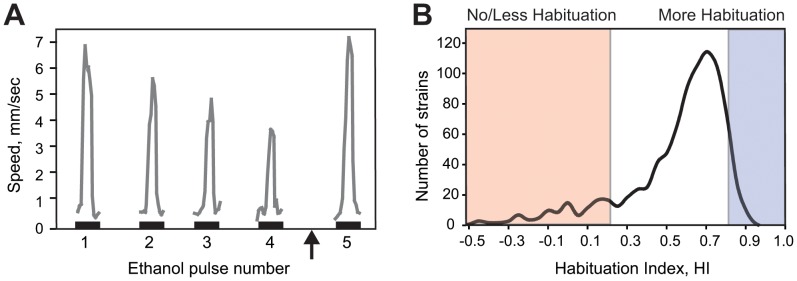

Drosophila habituates to an ethanol-induced olfactory startle.
A) The olfactory startle attenuates with the characteristics of habituation. Ethanol naïve flies exposed to a 30-sec pulse of ethanol vapor showed an olfactory mediated startle response, characterized by a transient increase in locomotor activity. In subsequent pulses of ethanol vapor the olfactory startle increasingly attenuated. To demonstrate habituation (and not sensory adaptation or fatigue) flies were dishabituated (arrow) with a mechanical stimulus before the final pulse of ethanol. B) The frequency distribution of habituation indices (HI) of all strains tested in the genetic screen. The habituation index was calculated as a ratio of the total movement in the fourth pulse (P4) and first pulse (P1) (HI = 1-P4/P1; a HI of 1 indicates complete habituation while a HI of 0 or lower indicate no habituation or sensitization, respectively). A frequency distribution of the habituation indices showed a near normal distribution with a mean of 0.58, median of 0.64 and mode of 0.65. A HI of 0.8 or higher was used as the cut-off for enhanced habituation, while a HI of 0.2 or lower was the cut-off for failure to habituate normally. Strains with low and high HIs were selected for further analysis.